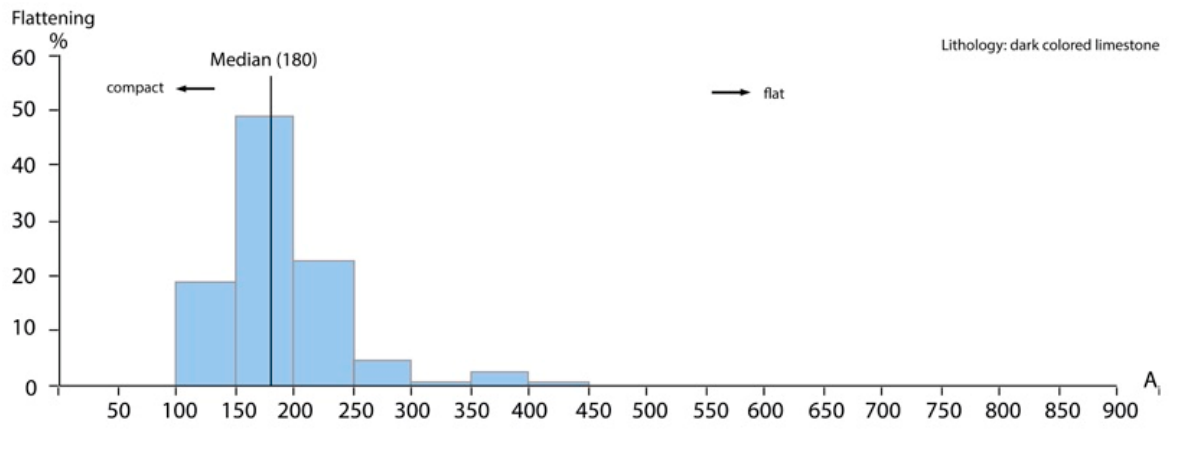
Figure 7. Histogram illustrating flattening index of clasts at the Möhlin site. The results of the cosmogenic 10 Be and 26 Al measurements are displayed in Table